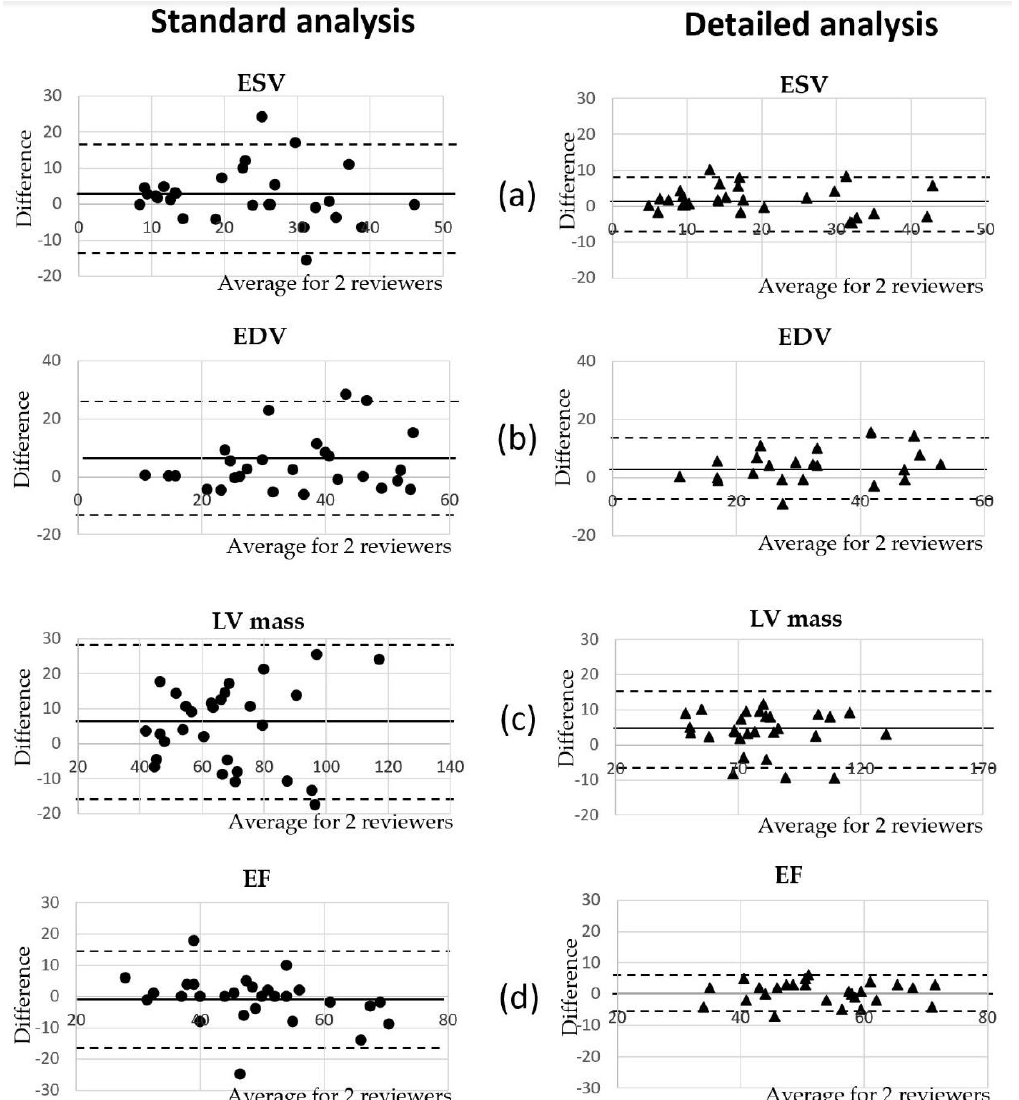
Figure 5. Bland–Altman analysis of the interobserver variability for two reviewers using the same Philips ISP software. The solid line represents the mean difference of each parameter assessment by the different reviewers; the broken lines mark the 1.96% standard deviation of the mean differences in measurements. The mean values obtained by the two reviewers are plotted in the x-axis; the differences between measurements of the two reviewers (reviewer 1–reviewer 2) are plotted on the y-axis. The panels ( a – d ) show interobserver variability in measurements of ESV, EDV, LV mass and EF, correspondingly.